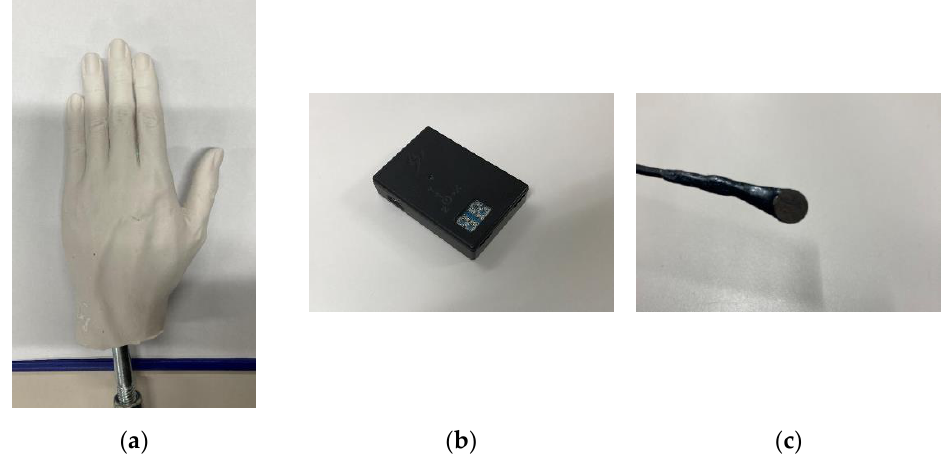
Figure 1. Hand model and sensors used in Experiment 1. ( a ) Silicone hand model measured 0.19 m × 0.095 m × 0.04 m (length × width × thickness). Projected area of hand model measured 0.014 m 2 . ( b ) Waterproof IMU measured 38 mm × 53 mm × 11 mm. IMU weighed 32 g. ( c ) Pressure sensor measured 0.6 mm in thickness and 6.0 mm in diameter.